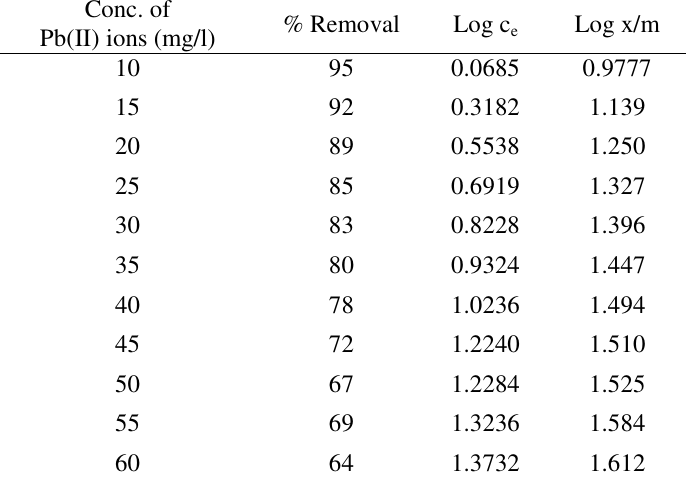
Table 4 . Data for Freundlich plot for adsorption of Pb(II) ions Carbon dosage - 50mg/50ml; p H- 5.0 + 0.2; Agitation time - 90min Conc.